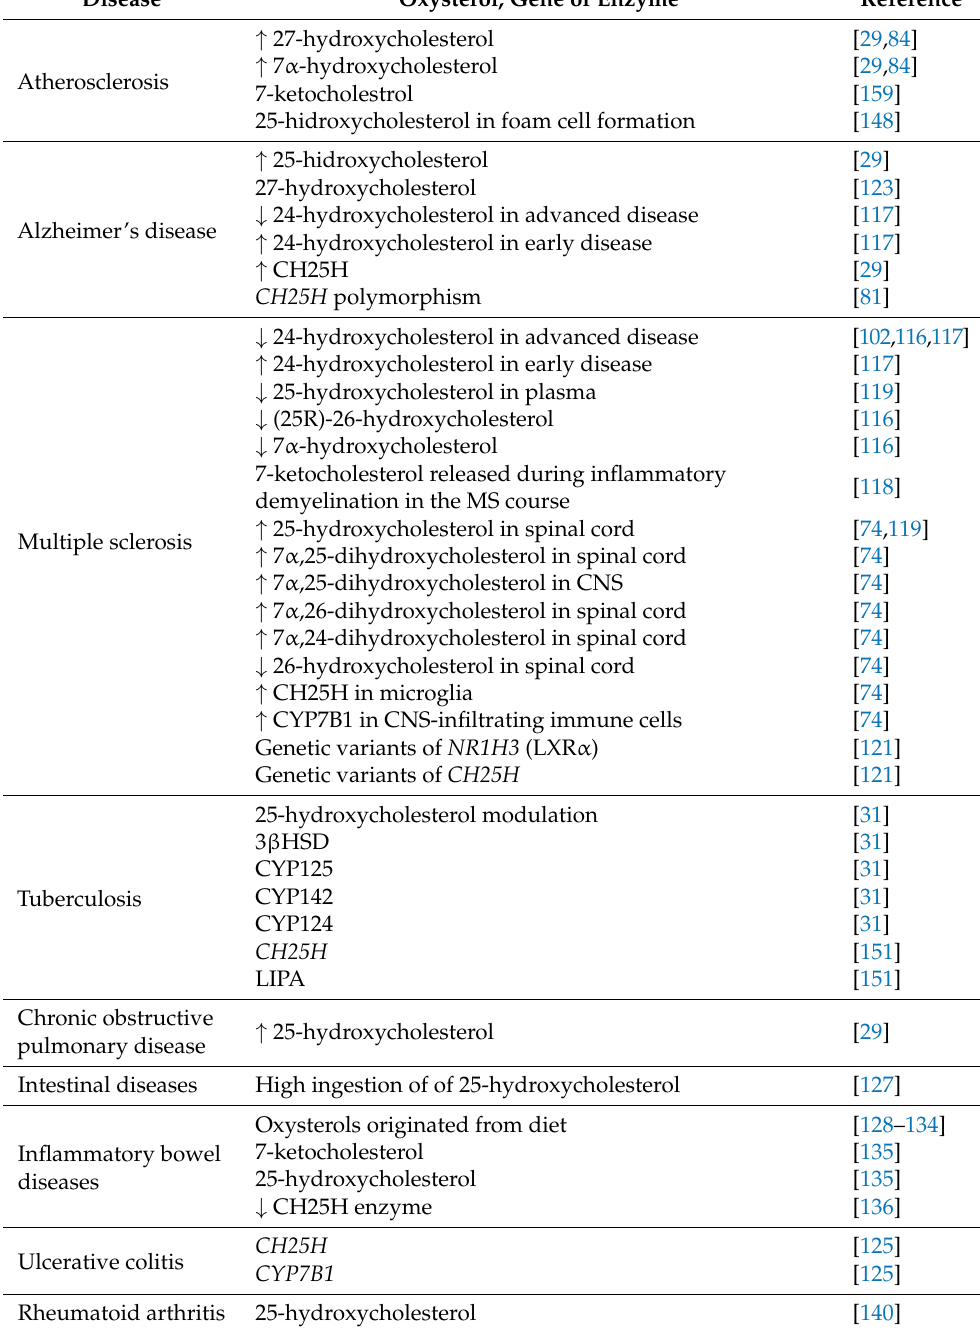
Table 1. Oxysterols and related gene, receptors or enzymes involved with immune-related diseases.